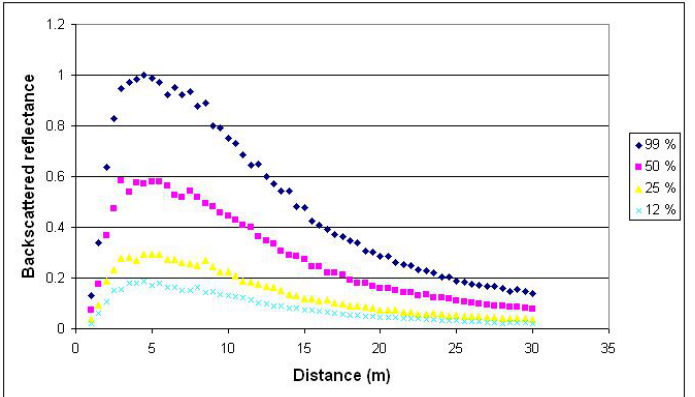
Figure 4. LEICA: 2009 distance measurement (profiler mode) normalised with 99% Spectralon standard at 4.5 m